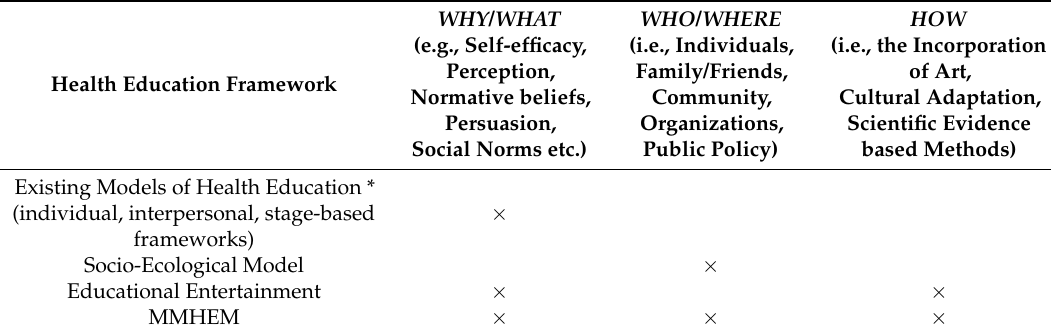
Table 2. The comparison of MMHEM to the existing evidence-based health education models and their major